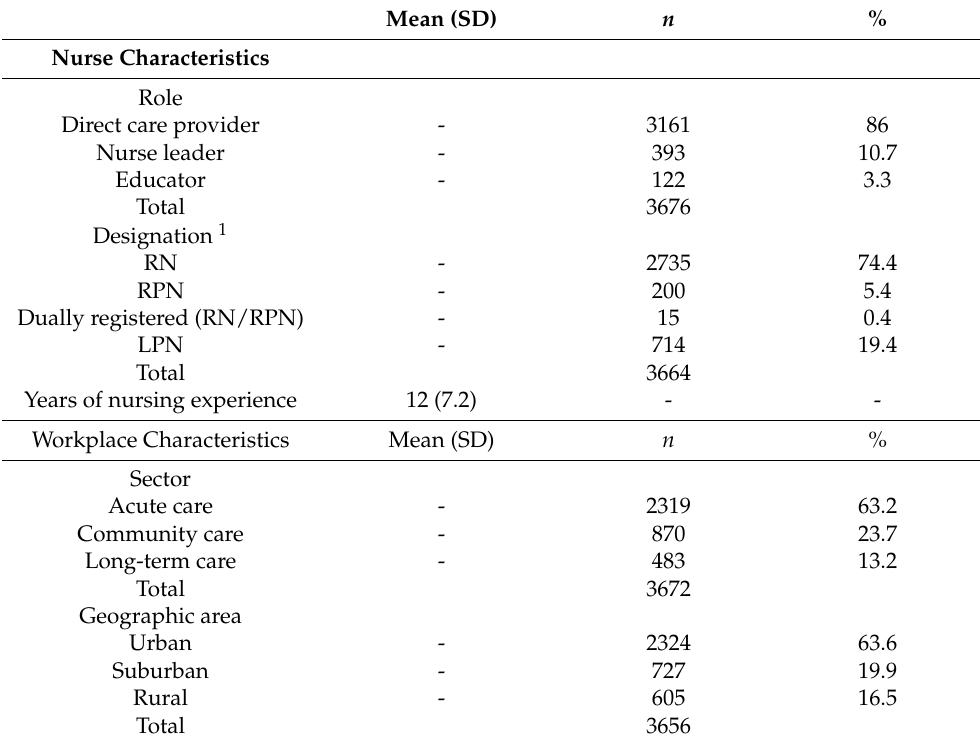
Table 1. Descriptive statistics on nurse characteristics and workplace